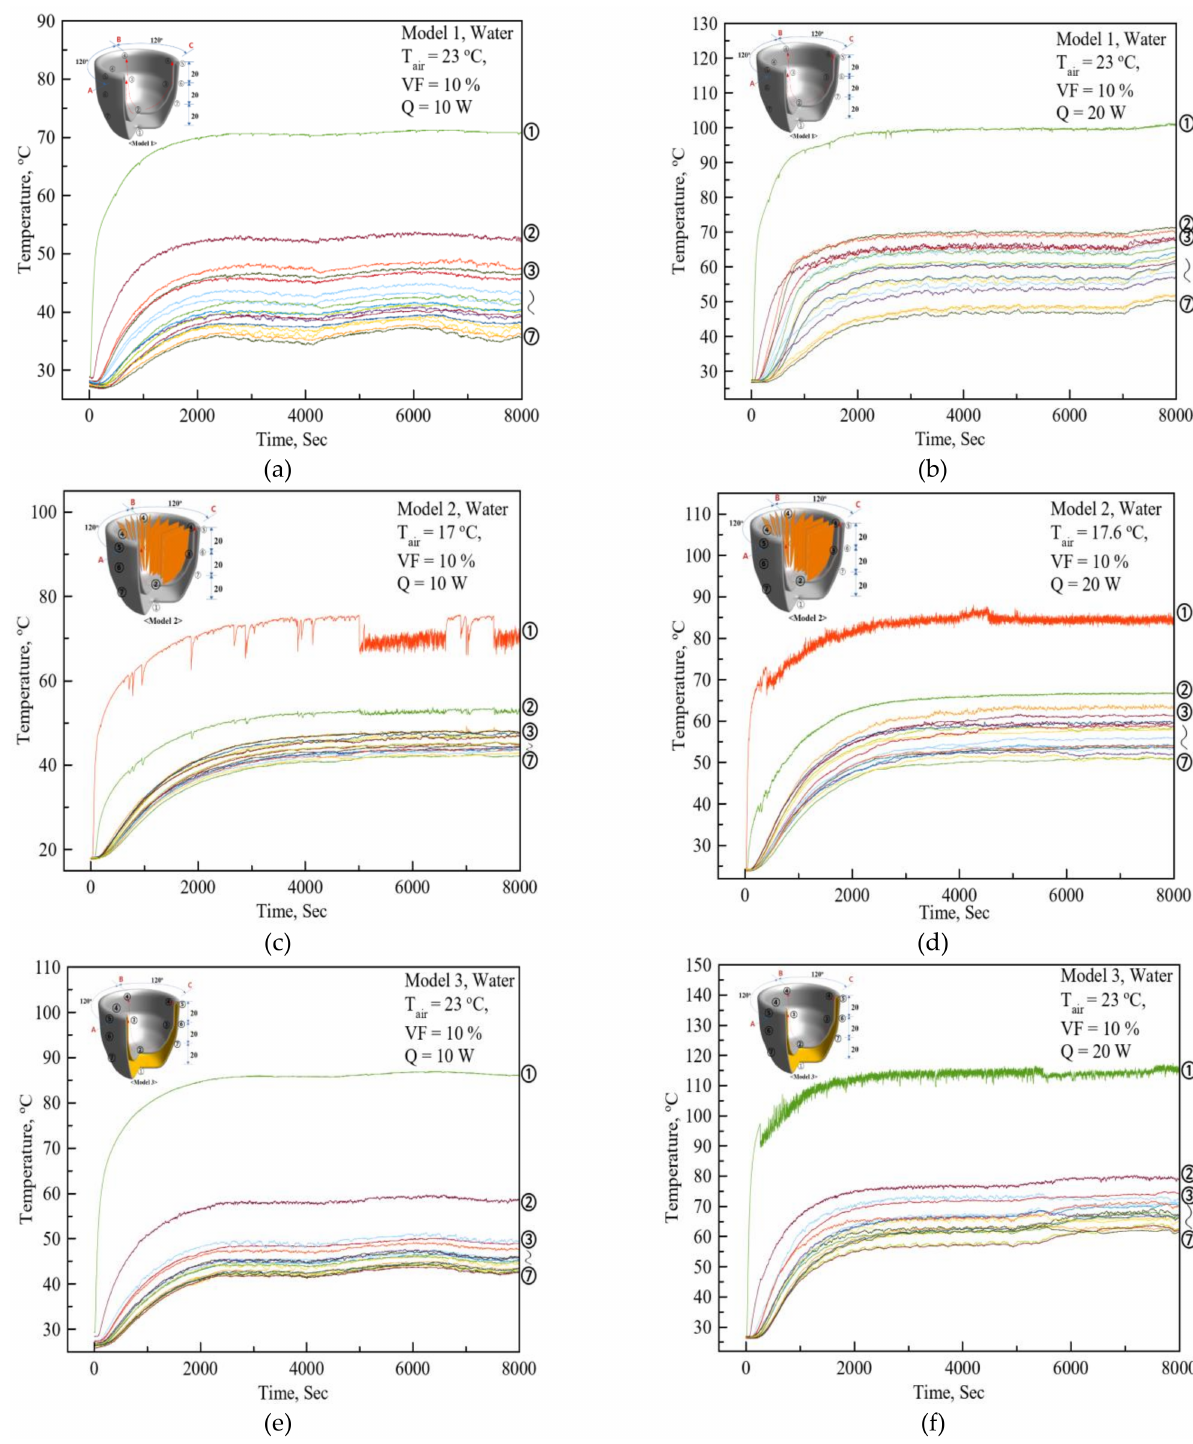
Figure 11. Temperature profile in the three directions of the HSVC. ( a ) Model 1, VF =10%, Q = 10 W. ( b ) Model 1, VF = 10%, Q = 20 W. ( c ) Model 2, VF = 10%, Q = 10 W. ( d ) Model 2, VF = 10%, Q = 20 W. ( e ) Model 3, VF = 10%, Q = 10 W. ( f ) Model 3, VF = 10%, Q = 20